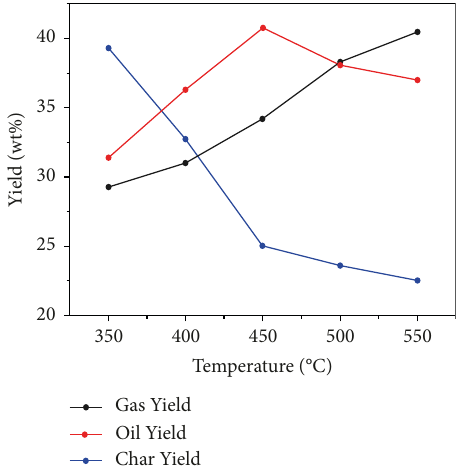
Figure 3: Effect of temperature on pyrolysis of Ficus benghalensis .